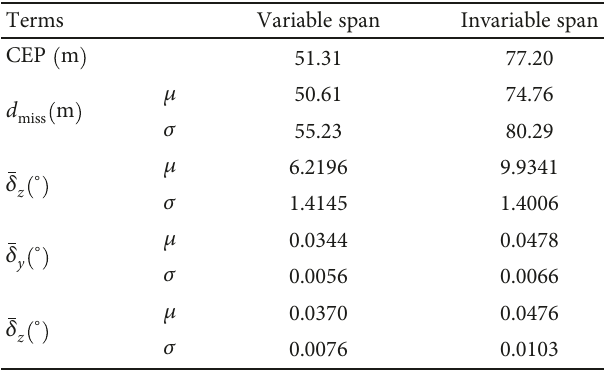
Table 6: Results of Monte Carlo simulation experiments.